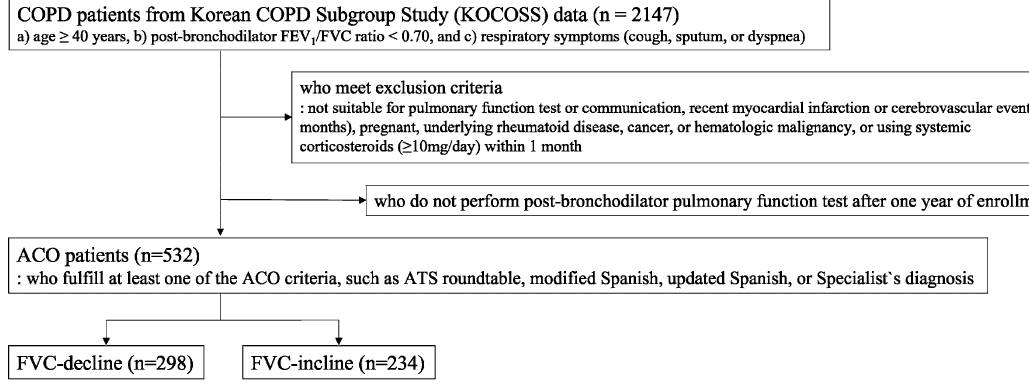
Figure 1. Flowchart of this study. Patients were extracted from KOCOSS study (n = 2147) who meet the COPD definition. If they satisfy the exclusion criteria or do not perform the pulmonary function tests 1 year after, they were excluded. Overall, 532 patients were finally enrolled in this study. They were divided into FVC-decline and FVC-incline group. Characteristics were compared between FVC-decline and FVC-incline. ACO asthma-COPD overlap, ATS American Thoracic Society, COPD chronic obstructive pulmonary disease, FEV 1 forced expiratory volume in one second, FVC forced vital